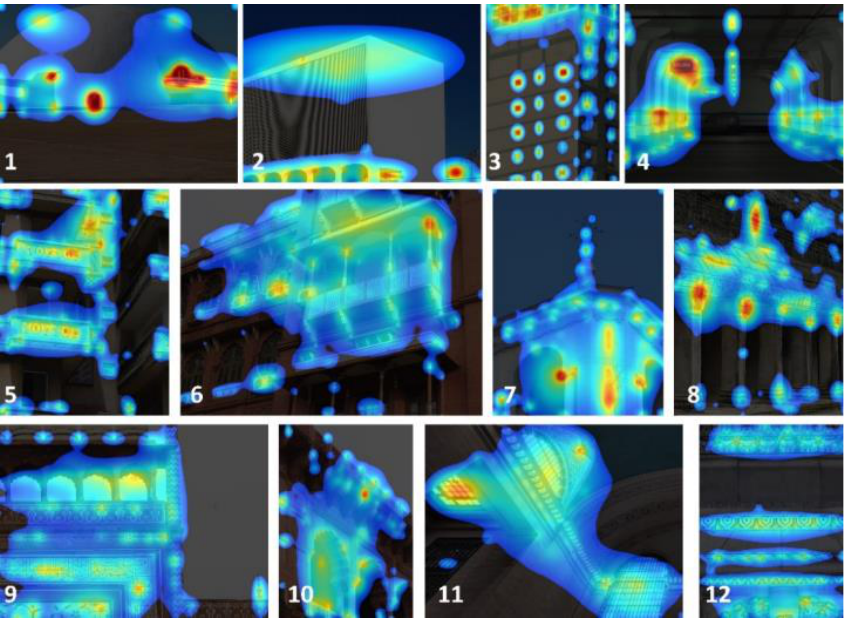
Figure 4. Heat maps of the “near” versio ns of the images of Figure 1, produced by